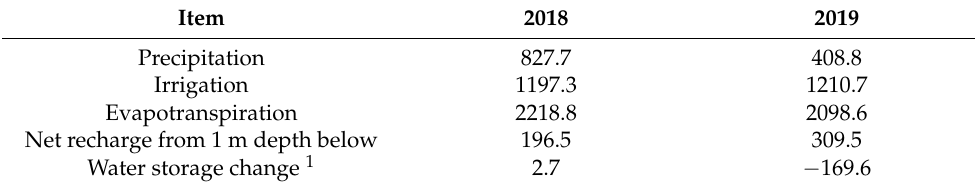
Table 4. Water balance of the 1 m-depth soil layer (unit: 10 4 m 3